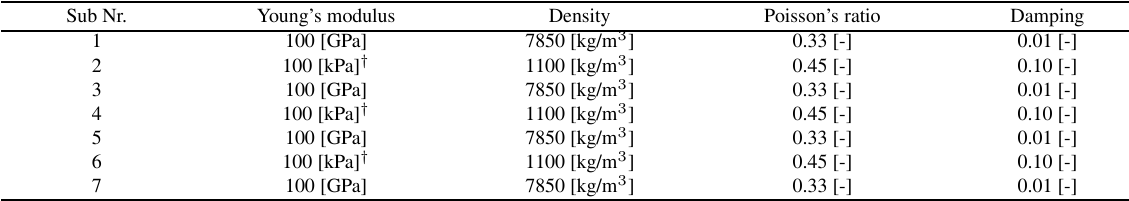
Material properties used in the test structure. The damping included is proportional damping Sub Nr.